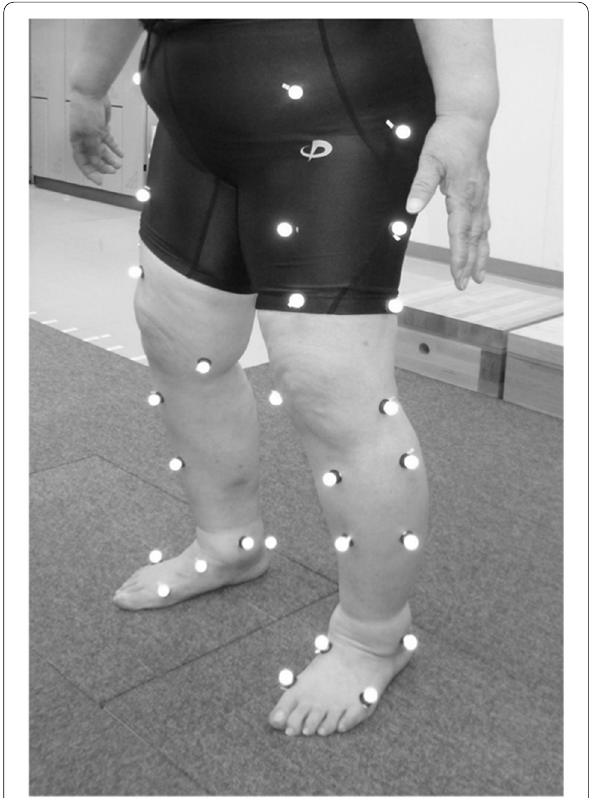
Fig. 1 Gait analysis using a motion analysis system in patients with knee